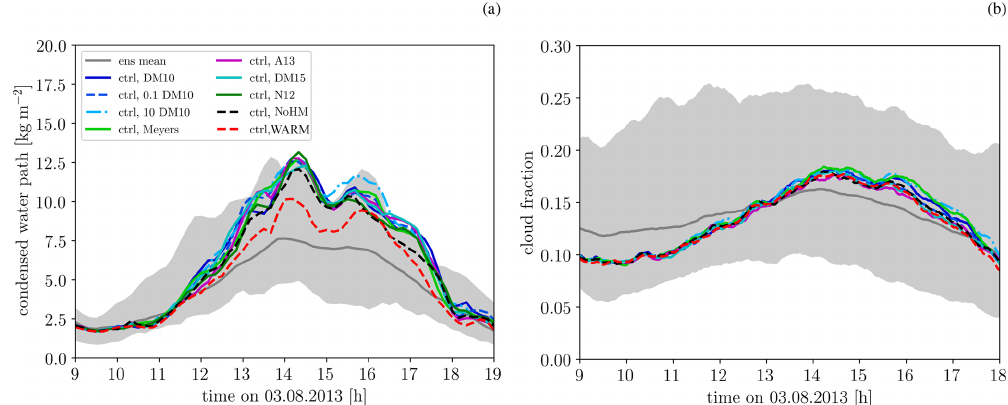
Figure 6. Time series of (a) the average condensed water path and (b) the cloud fraction. The dark grey shading in both panels shows the spread of the 10 ensemble members with perturbed initial conditions. The grey line represents the ensemble mean, and the various coloured lines represent simulations with different heterogeneous freezing parameterization, pure warm-phase microphysics, and no Hallett–Mossop process (colours according to